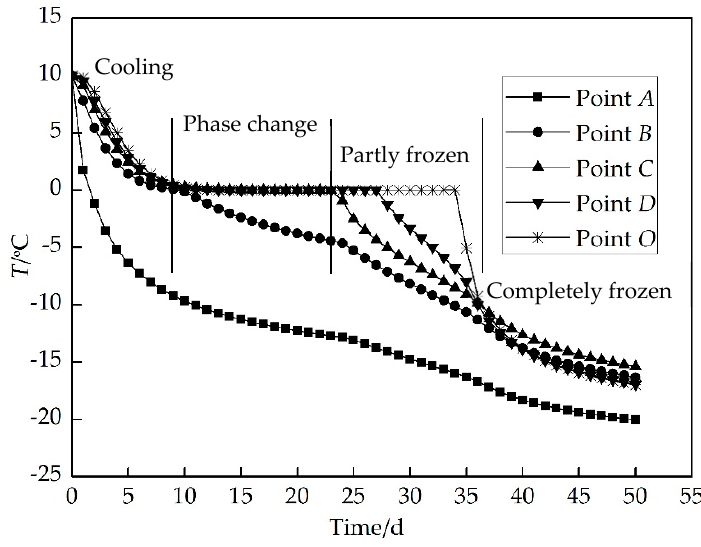
Figure 8. The time–history curves of temperature at the points A , B , C , D and O .